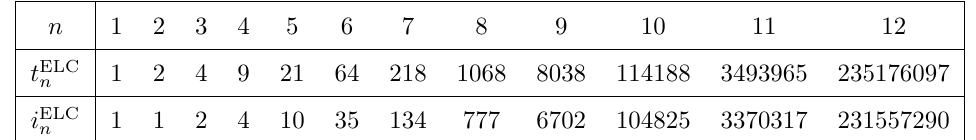
Table 1 . Number of equivalence classes of graphs under edge local complementation (ELC) t ELC for n ≤ 12 . Number of ELC equivalence classes of indecomposable graphs i ELC